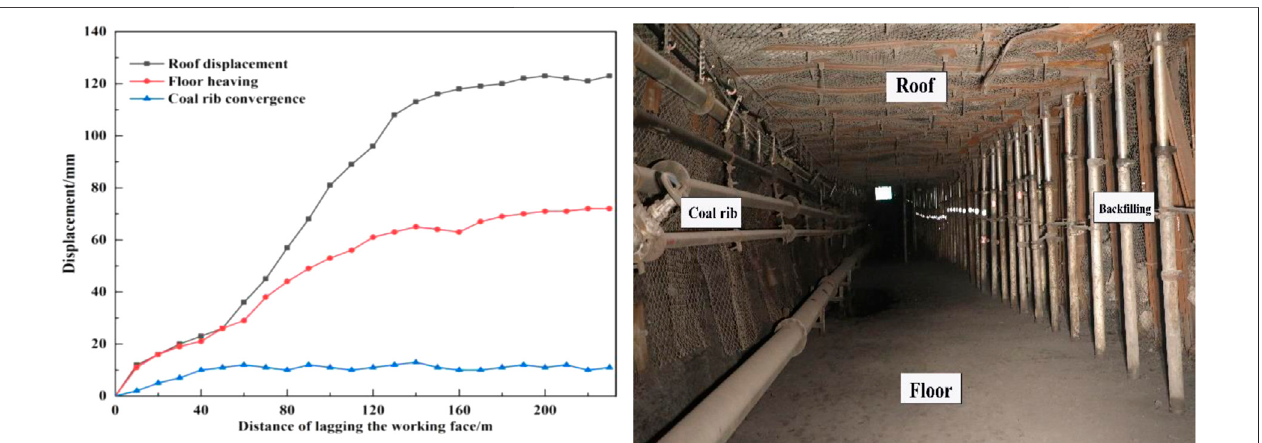
FIGURE 18 | Deformation of the surrounding rock of the